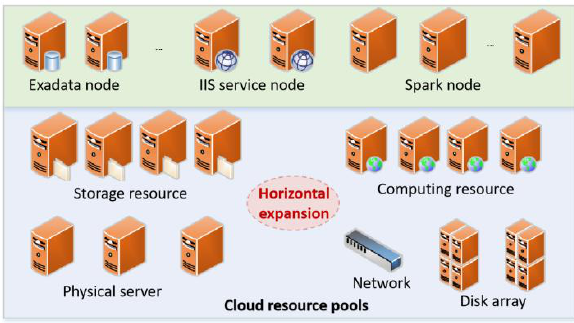
Figure 4. Topology diagram of the cloud resource pool.